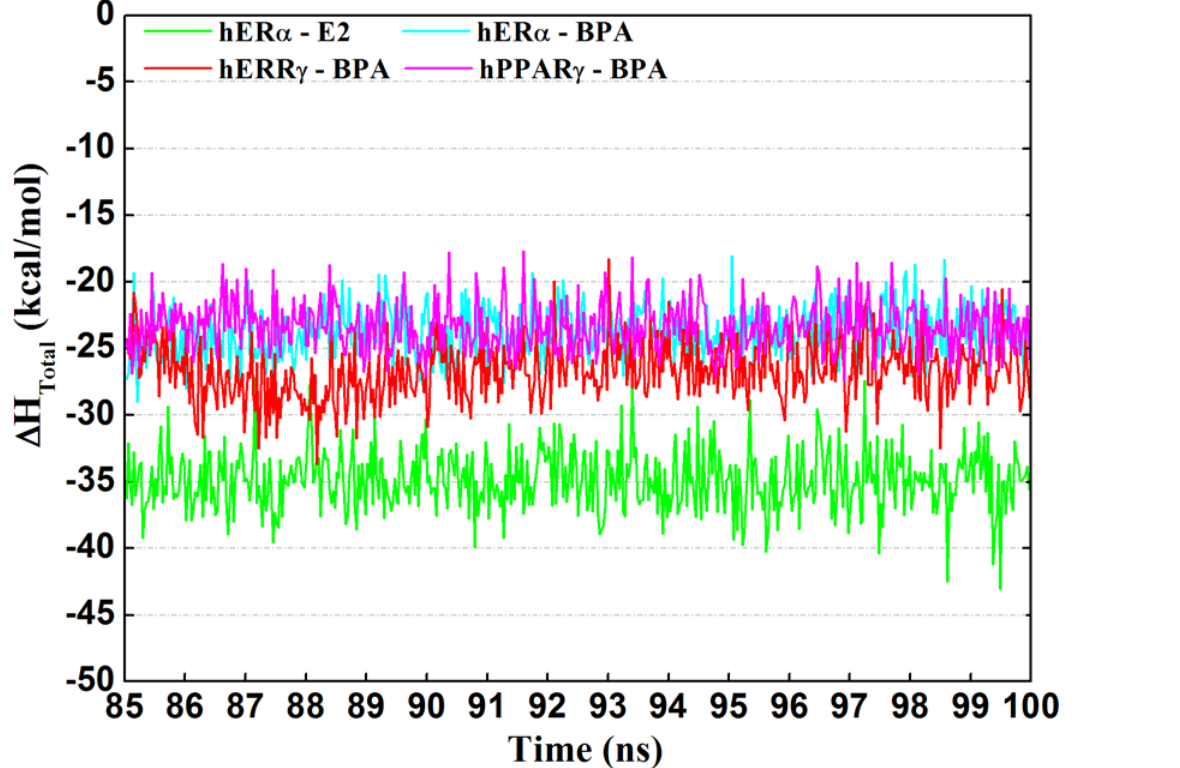
Fig 7. Enthalpy evolution against the last 15 ns of the four systems.